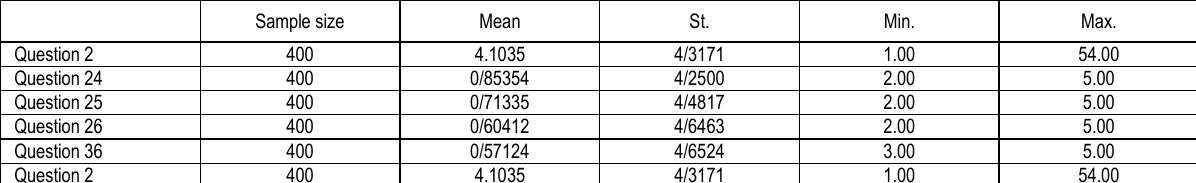
Table 13. Results of descriptive statistics (trust factors)